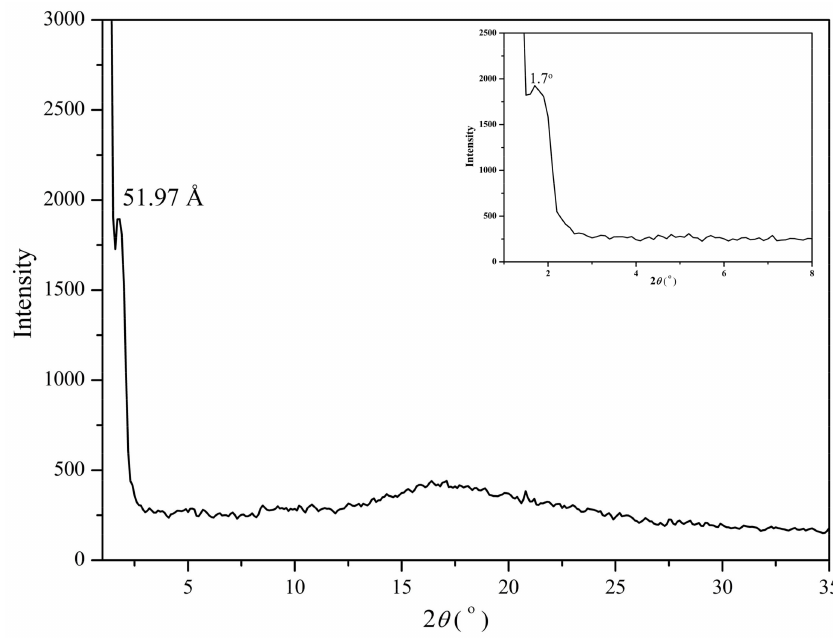
Figure 4. X-ray diffraction (XRD) pattern of mPEG 43 - b -P[(TMC-C) 20 -TMC 20 ] at 120 ◦ C.